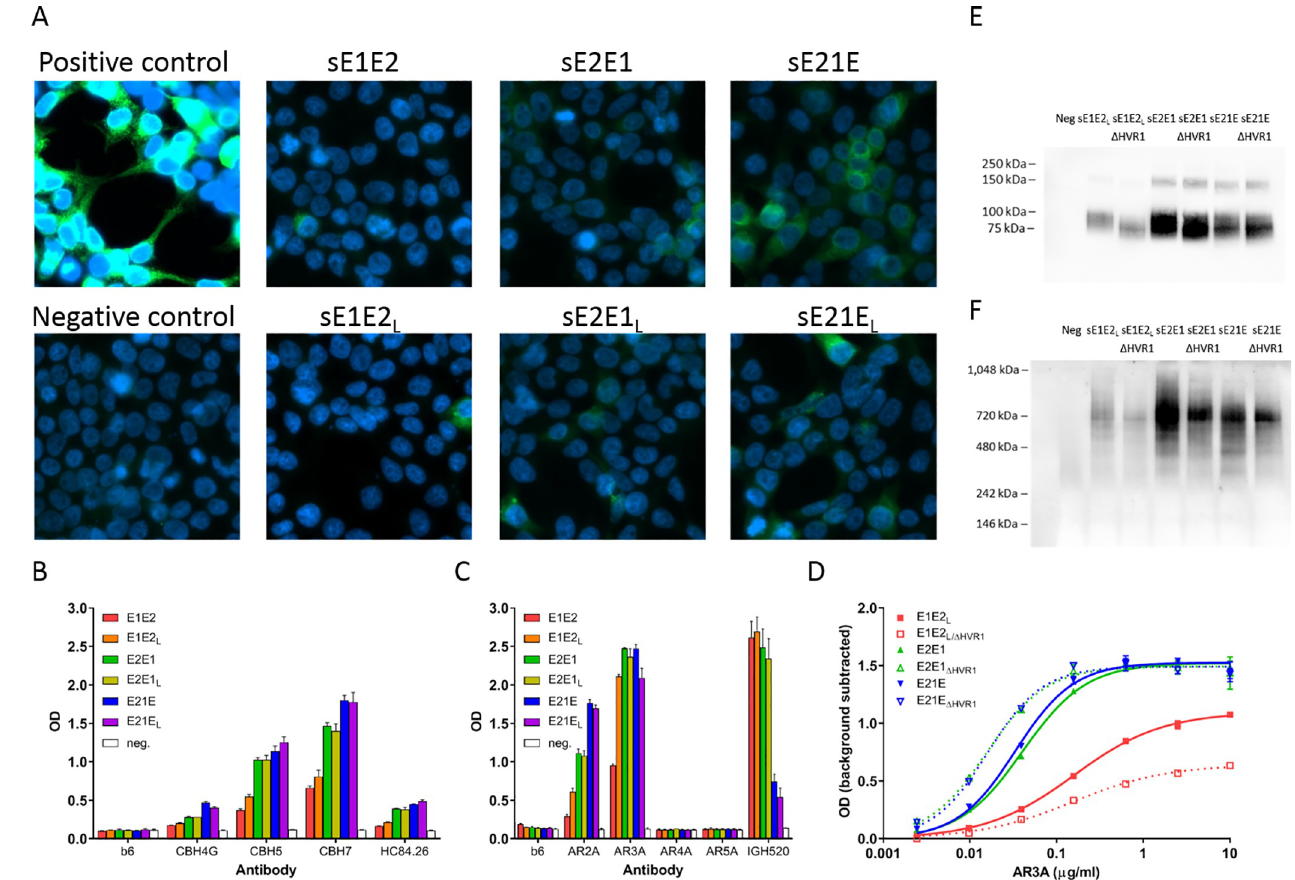
Fig 2. Antigenicity testing by ELISA of recombinant sE1E2, sE2E1 and sE21E with and without linker (L) between E1 and E2 and/or HVR1. A) HEK 293T cells were transfected with expression vectors for the indicated proteins with or without a linker, GGSAWSHPQFEKGG, and stained using the HCV NAb, AR3A. Positive control is full-length J6 E1E2 (high signal due to full cellular retention via non-truncated TM domains) and negative control is empty vector. B-D) The indicated affinity purified proteins were bound to 96 well maxisorp plates by overnight incubation at 4˚C followed by blocking using BSA for 1h. Subsequently the proteins were incubated with (B and C) a single high dose (5 μ g/ml) of the indicated human primary anti-HCV envelope antibodies and b6 control antibody or D) a dilution series of the antibody AR3A. Binding was measured by HRP-coupled anti-human antibody followed by colorimetric optical density (OD) reading at 450 nm of the developed TMB substrate signal. E and F) HEK 293T cells were transfected with plasmids encoding expression in mammalian cells of sE1E2 L , sE2E1 and sE21E with and without HVR1. Following 72h, supernatants were collected and subjected to SDS-PAGE under reducing conditions or native-PAGE (See S1 Raw images for uncropped and unmodified blots). E) Following SDS-PAGE the proteins were transferred onto a PVDF membrane and probed using E2-specific antibody, AP33, which was visualized using chemiluminescence with an HRP-coupled anti-mouse antibody. F) Following native-PAGE the proteins were transferred onto a PVDF membrane and probed using E2-specific antibody, AR3A, which was visualized using chemiluminescence with an HRP-coupled anti-human antibody. Neg is negative control and represents transfection with empty